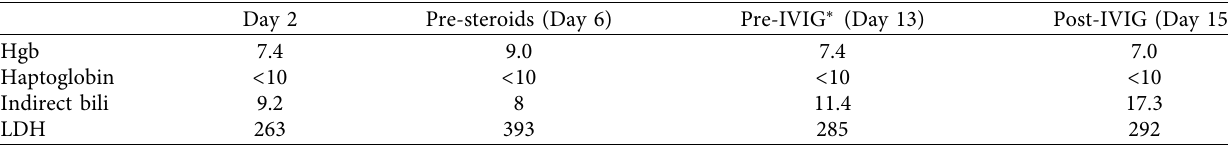
Table 3: Hemolysis panel during